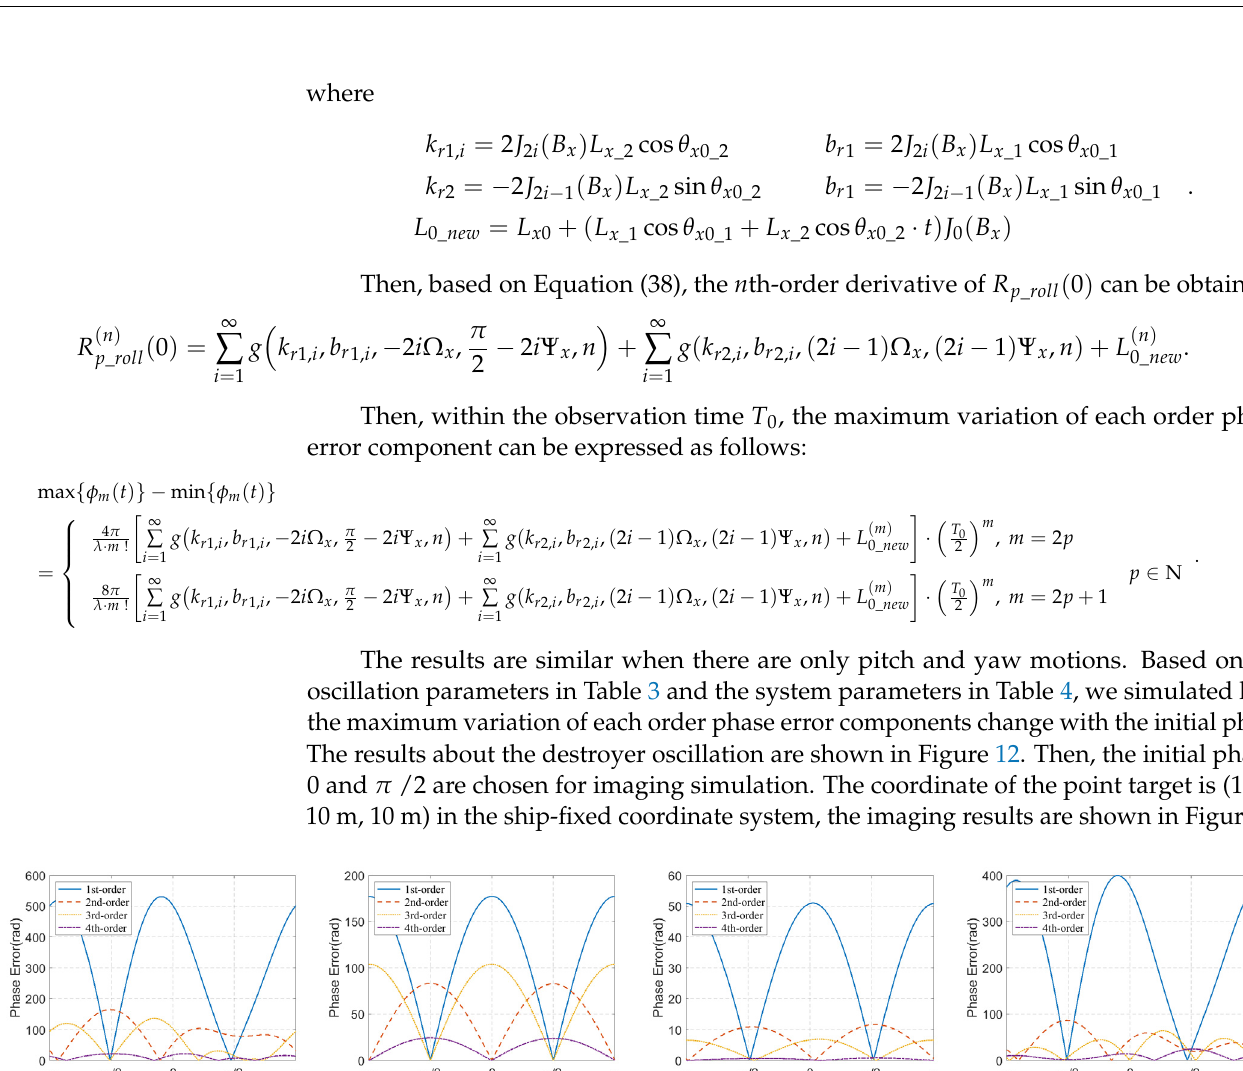
Figure 13. Focusing results of the point target with angular oscillations of the destroyer on sea-state 5. ( a ) Roll motion, Ψ = ; ( b ) pitch motion, 0 x